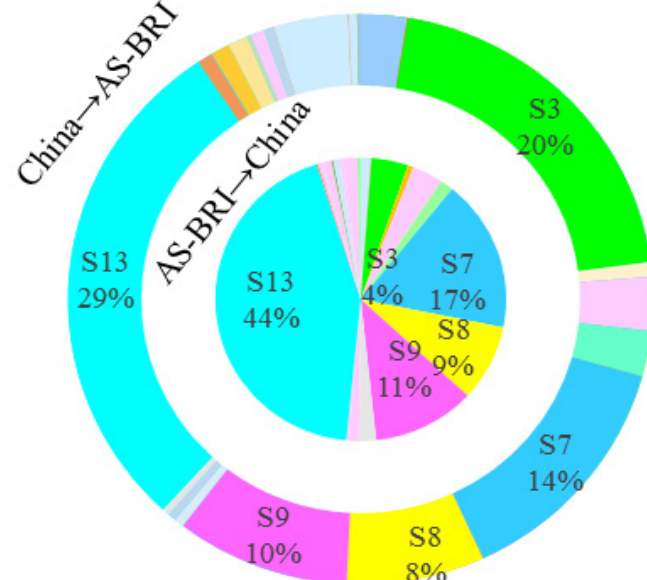
Figure 3. Sectoral CSE between China and ALL-BRI.